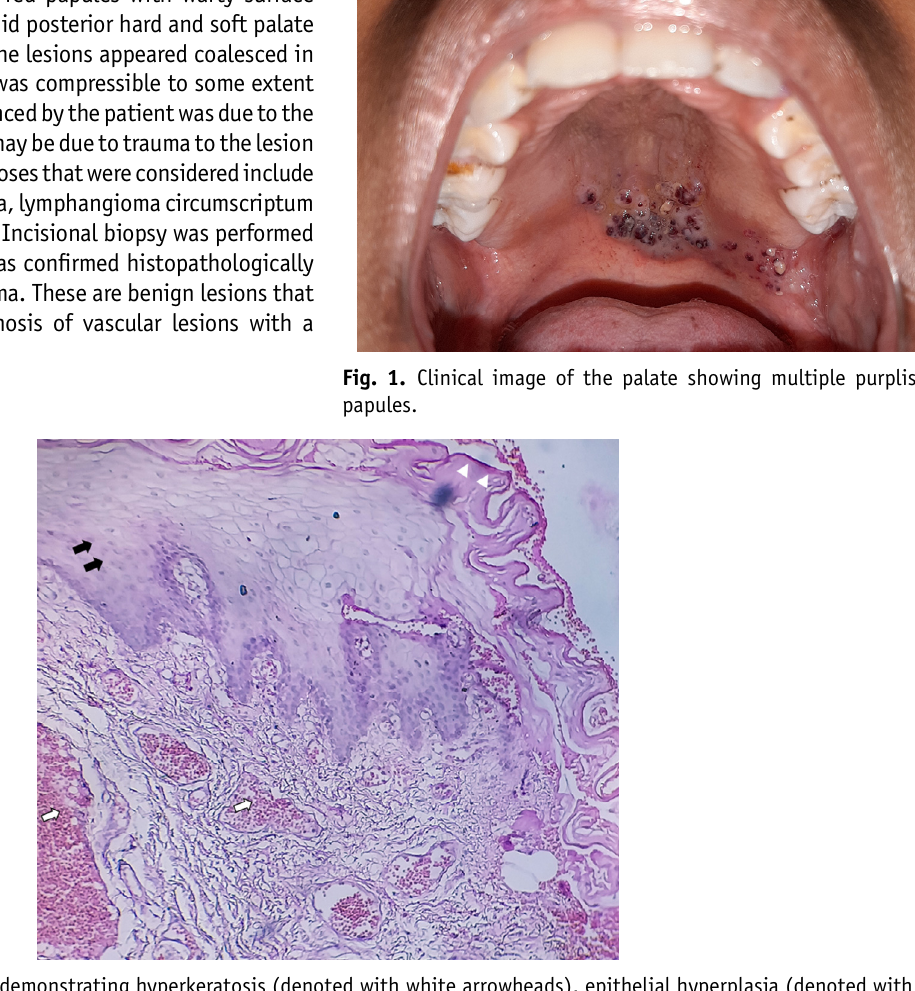
Fig. 2. Histopathological section demonstrating hyperkeratosis (denoted with white arrowheads), epithelial hyperplasia (denoted with black arrows), papillomatosis with numerous blood fi lled vascular proliferations within the connective stroma (denoted with white